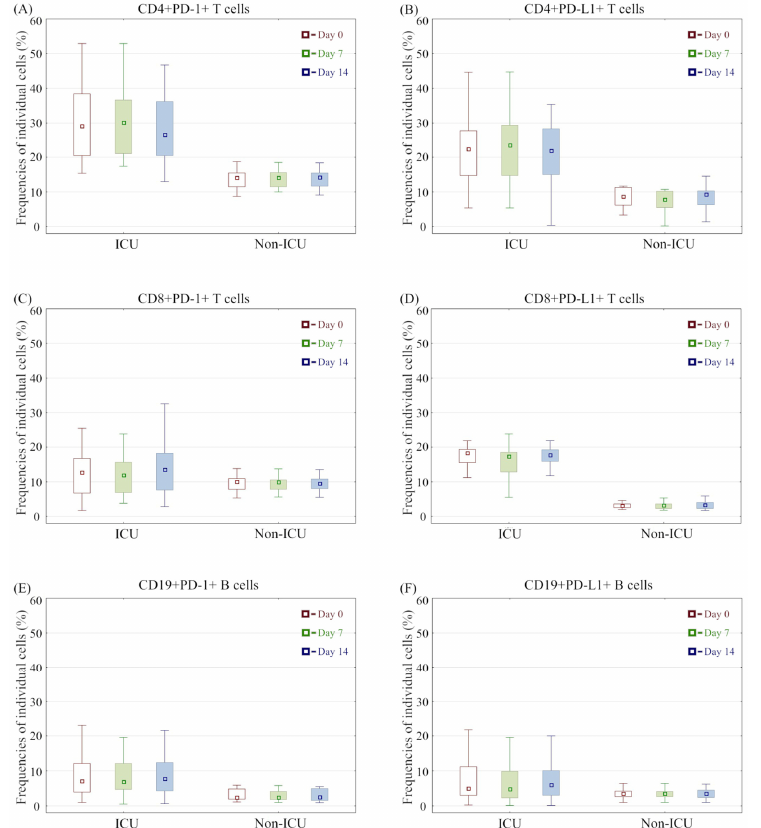
Figure 1. ( A – F ) Whisker–box plots for lymphocyte percentages over time among patients requiring mechanical ventilation (ICU group) and hospitalized patients without invasive oxygen support (non-ICU group). Medians are presented as squares inside boxes, interquartile ranges are presented as external box edges, and ranges are presented as whiskers. Percentages over time are shown for the subsequent collection days (baseline: red, day 7: green, day 14: blue).